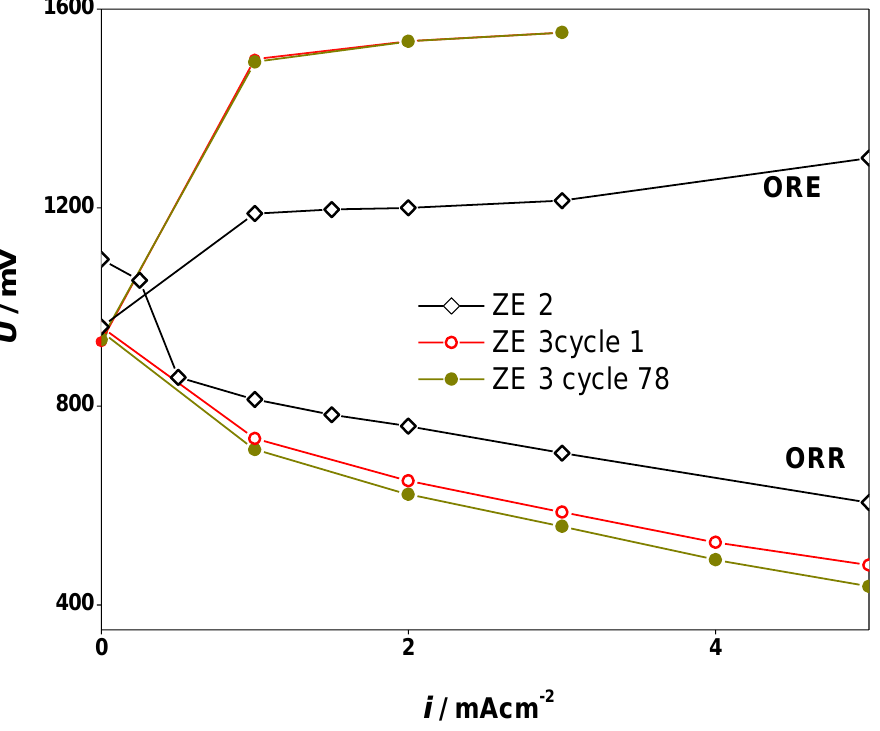
Figure 4. Volt-ampere characteristics of third-generation zeolite-based AE (ZE 3) during discharge and charge compared with ZE